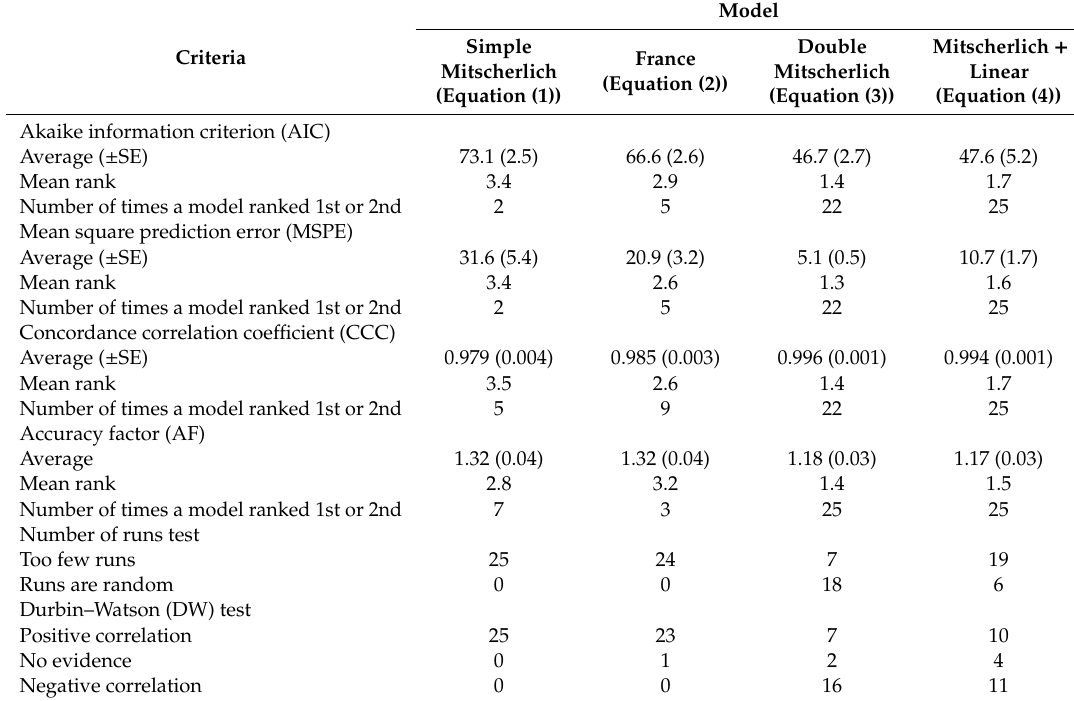
Table 4. Goodness-of-fit and analysis of residuals from fitting the four equations to the 25 datasets of Experiments 1 and